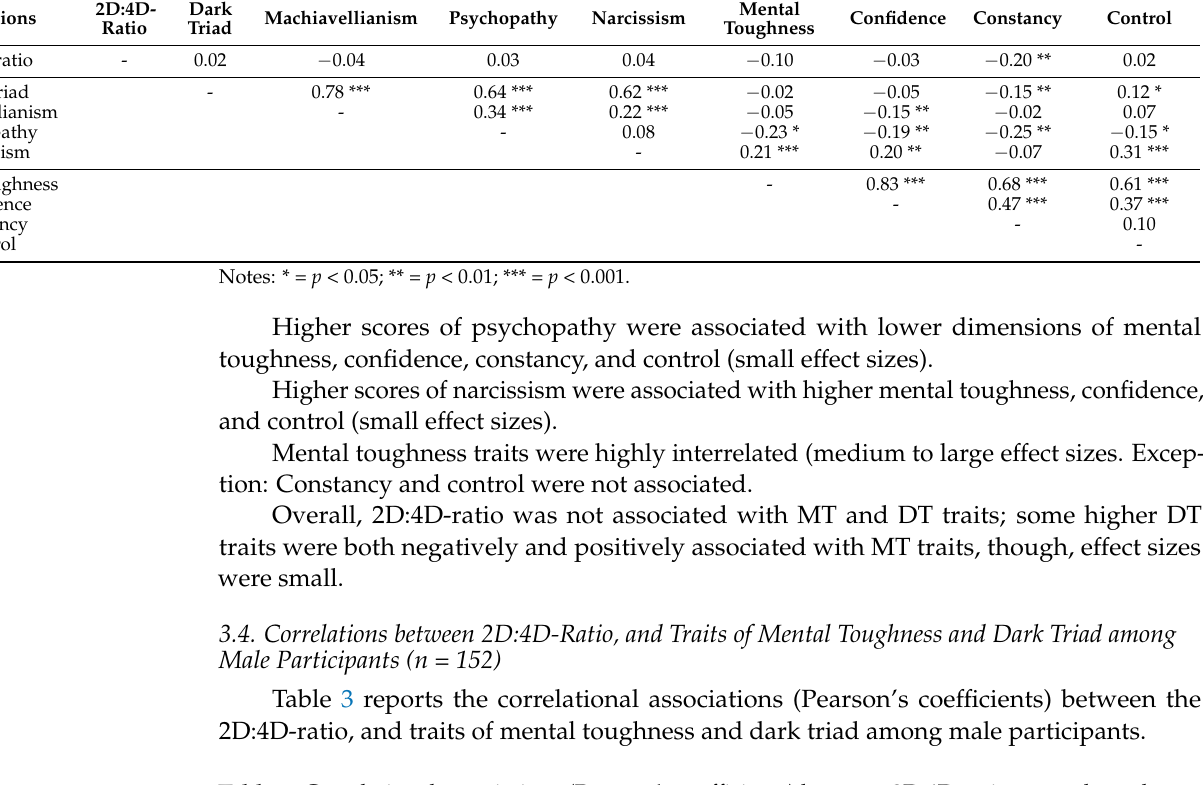
Table 3. Correlational associations (Pearson’s coefficients) between 2D:4D-ratio, mental toughness, and dark triad traits among male participants ( n =